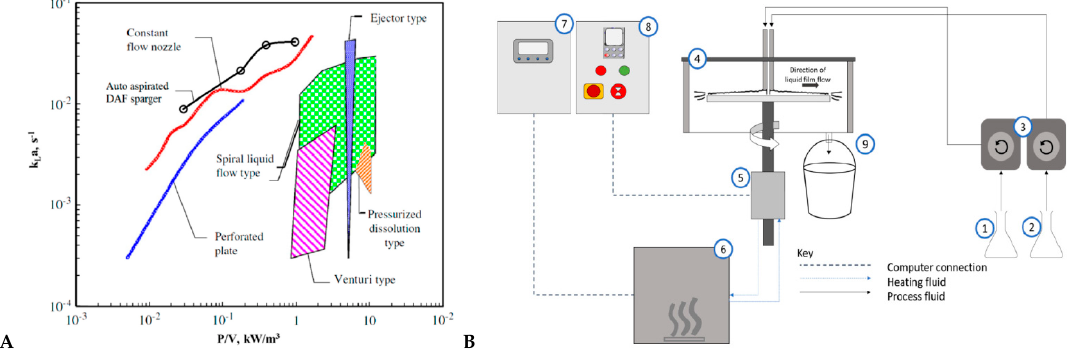
Figure 4. ( A ) Specific power requirement for water aeration of various sparger types [6]. ( B ) Schematic of experimental set-up for spinning disc reactor (SDR) [7].